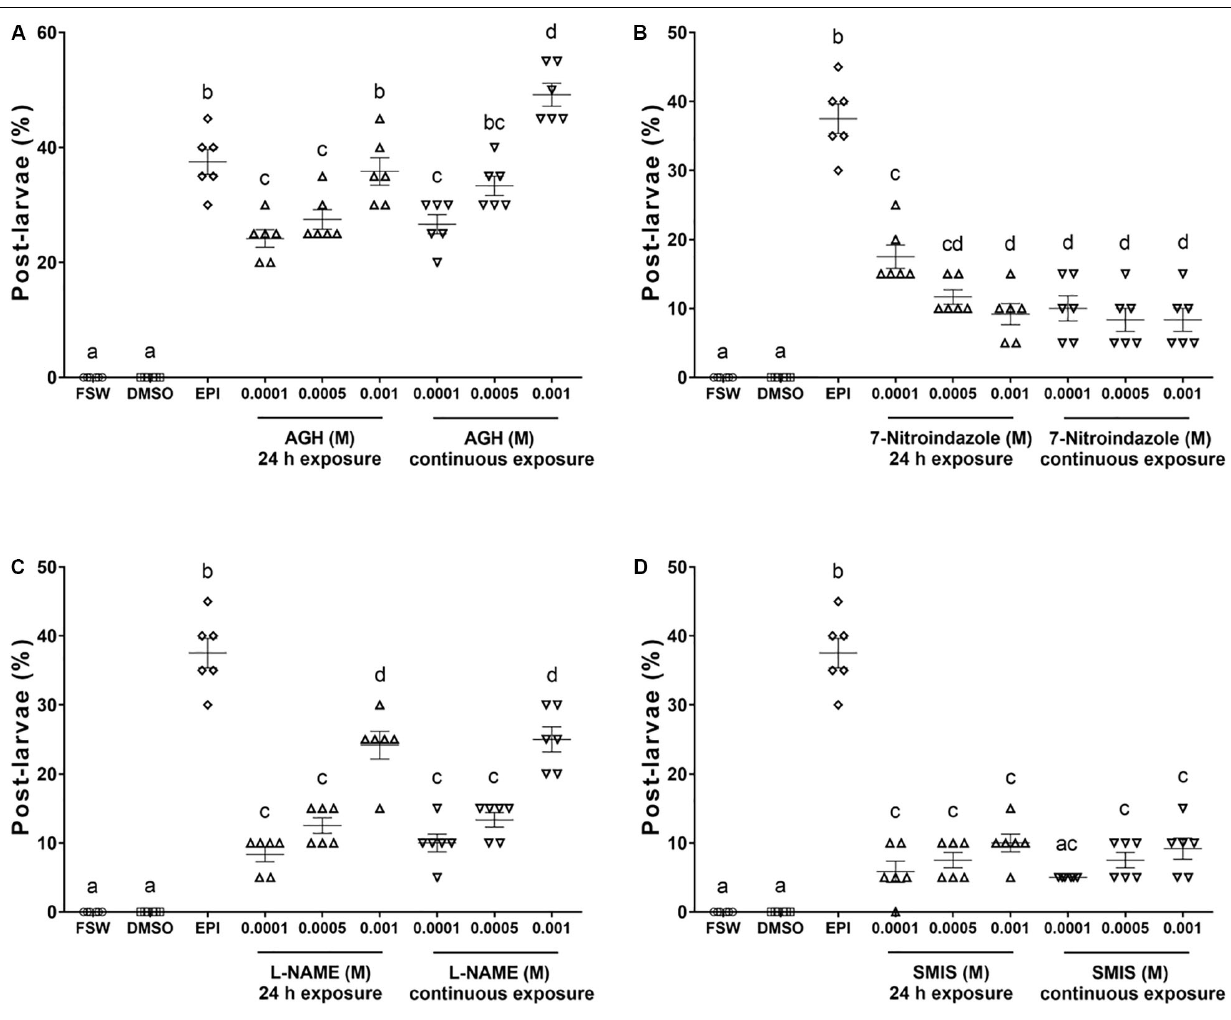
FIGURE 1 | Effect of nitric oxide synthase (NOS) inhibitors on the metamorphosis of M. coruscus larvae in 24-h and continuous exposure assays. Larvae were exposed to different concentrations of NOS inhibitors for 24 h or continuously for 96 h. The postlarvae rate was then measured at 96 h after treatment with aminoguanidine hemisulfate (AGH) (A) , 7-nitroindazole (B) , L -nitroarginine methyl ester ( L -NAME) (C) , or S-methylisothiourea sulfate (SMIS) (D) . Filtered seawater (FSW) and DMSO were used as negative controls, and the epinephrine (EPI) was used as a positive control. Data are shown as mean ± SEM ( n = 20) and were subjected to one-way analysis of variance. Significant differences ( p < 0.05) are represented by different letters. All bioassays were performed at 17 ± 1 ◦ C in the dark with six